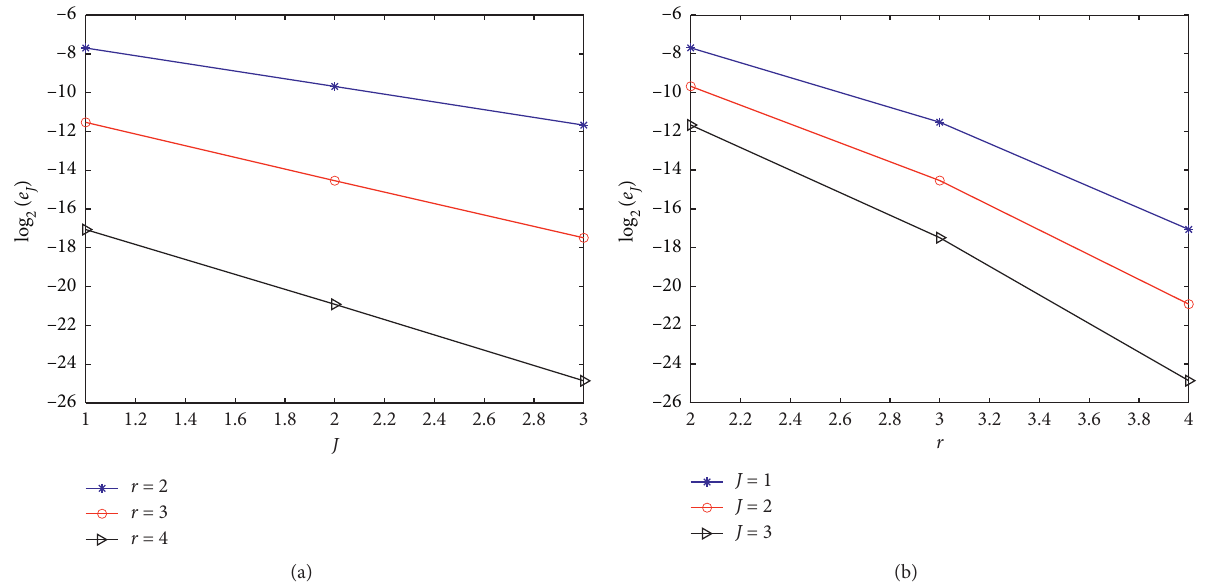
Figure 5: Effects of the multiplicity parameter r and refinement level J for Example 3.